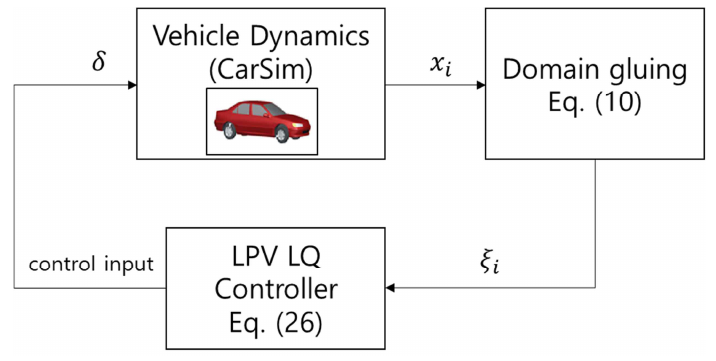
Figure 4. Block diagram of